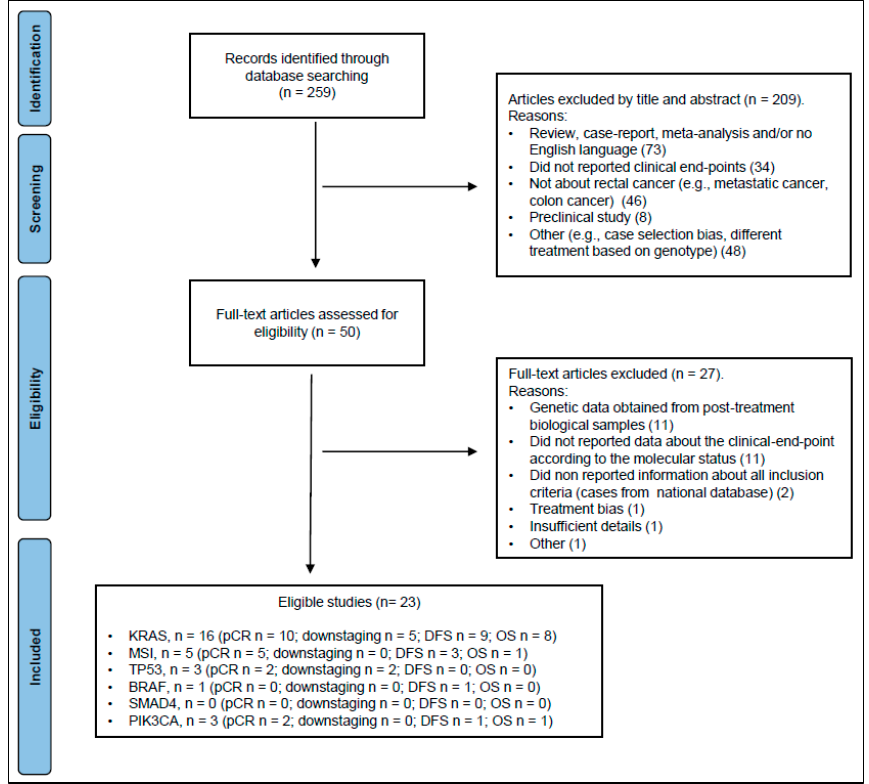
Figure 1. PRISMA flow diagram. Abbreviations: DFS, disease-free survival; OS, overall survival; pCR, pathologic complete response.